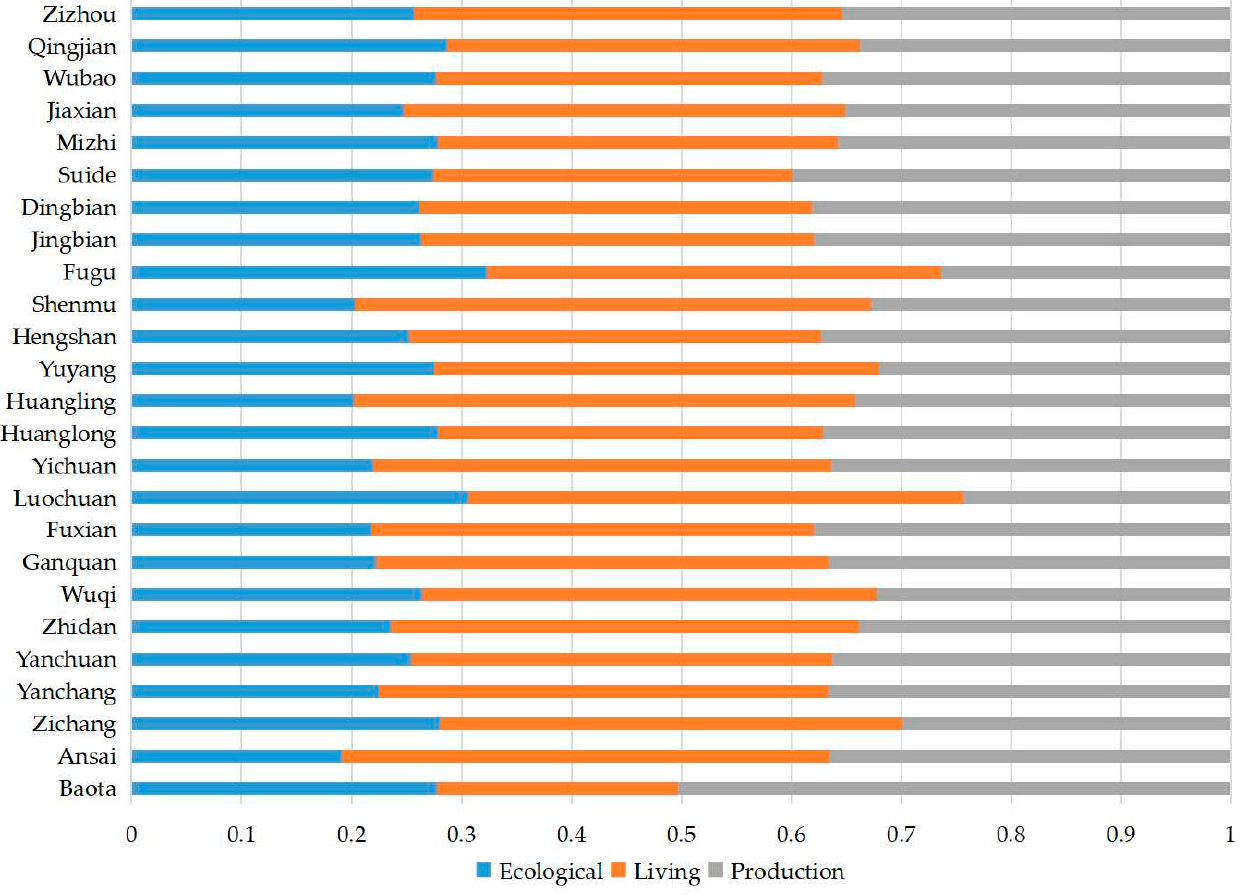
Figure 6. Barrier degrees of production–living–ecological on the enhancement of human settlement environment in northern Shaanxi from 2000 to 2010.